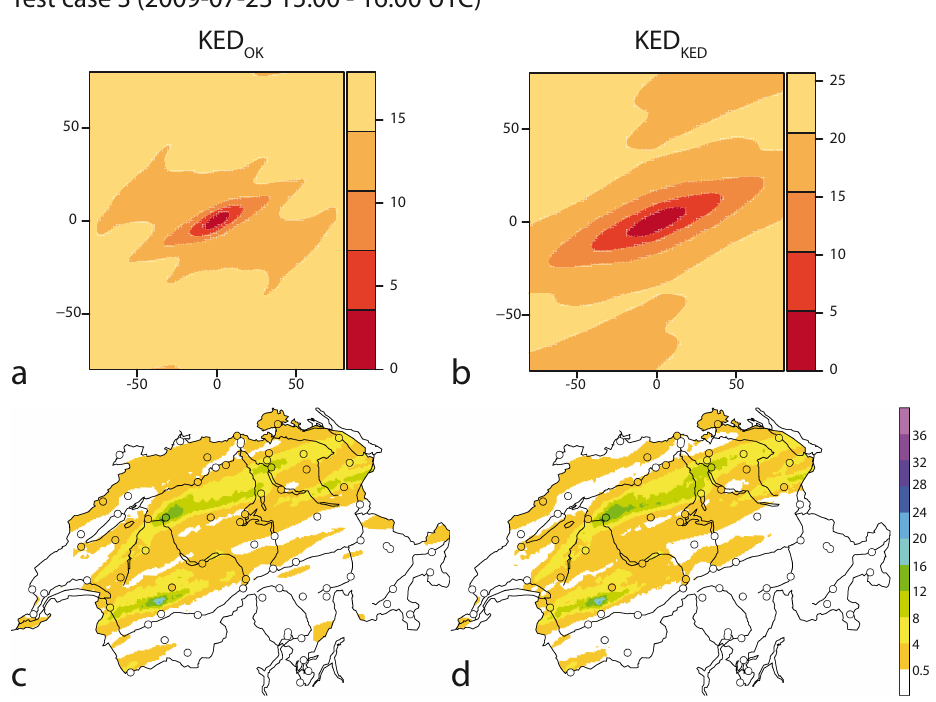
Fig. 11. As Fig. 7 but for test case 3.